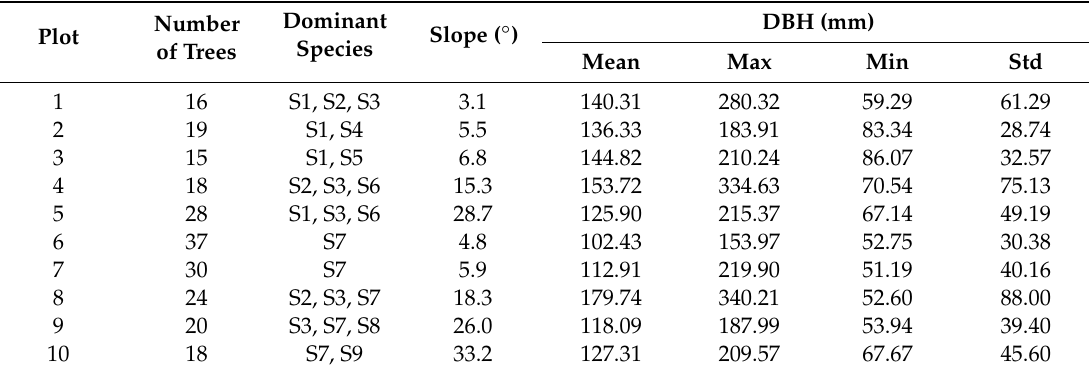
Table 2. Descriptive statistics of the sample plots 1